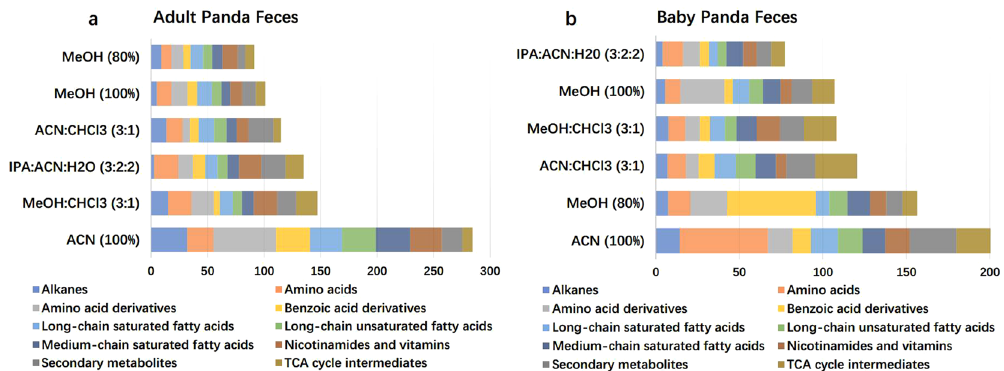
Figure 4. The bar chart represents the cumulative coefficient of variations (CV) of ten different biochemical classes using six different extraction solvents. ( a ) CVs of the fecal metabolome from adult giant panda. ( b ) CVs of the fecal metabolome from baby giant panda. The major metabolite classifications are alkanes, amino acids, amino acid derivatives, benzoic acids and derivatives, long-chain saturated fatty acids, long-chain unsaturated fatty acids, medium-chain saturated fatty acids, nicotinamides and vitamins, and secondary metabolites, and TCA cycle intermediates. The x-axis is the total CV for all major metabolite